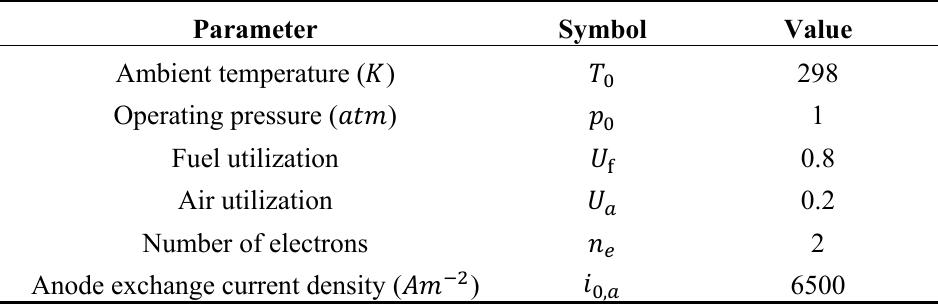
Table 1. Constants used for the fuel cell